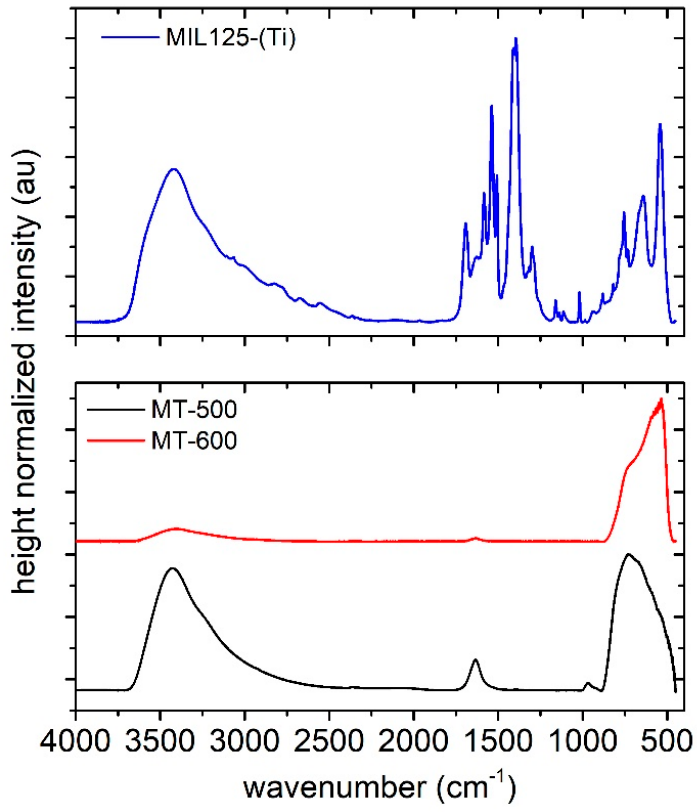
Figure 6. ( Top ) panel: Height normalized MIL125-(Ti) FTIR spectrum; ( Bottom ) panel: Height normalized MT-500 and MT-600 FTIR spectra.